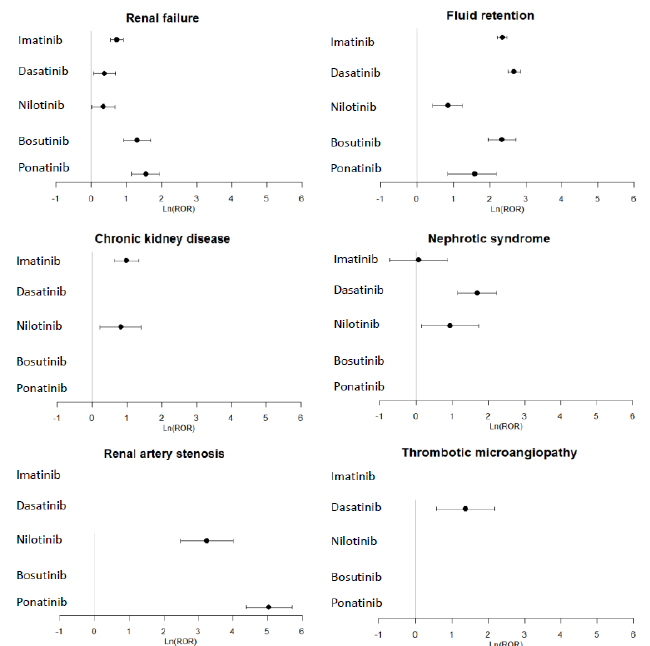
Figure 1. Forest plot of disproportionality (ROR) of tyrosine kinases and renal failure, fluid retention, chronic kidney disease, nephrotic syndrome, renal artery stenosis, and thrombotic microangiopathy events (MeDRA PTs). RORs were calculated when more than five cases were reported for one drug.